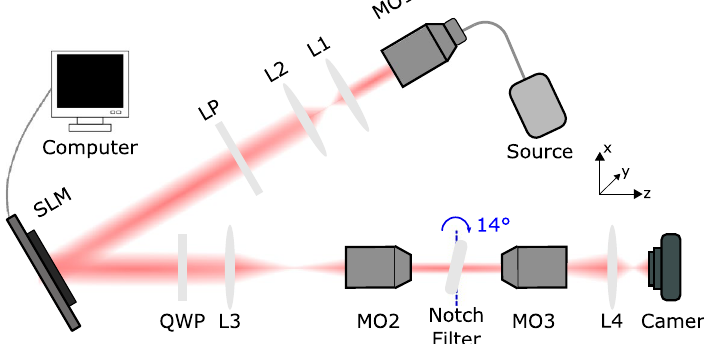
Figure 3. The experimental configuration for image processing with a spatial light modulator (SLM), where L and MO denote lenses and microscope objectives, respectively. The schematic is not to scale.